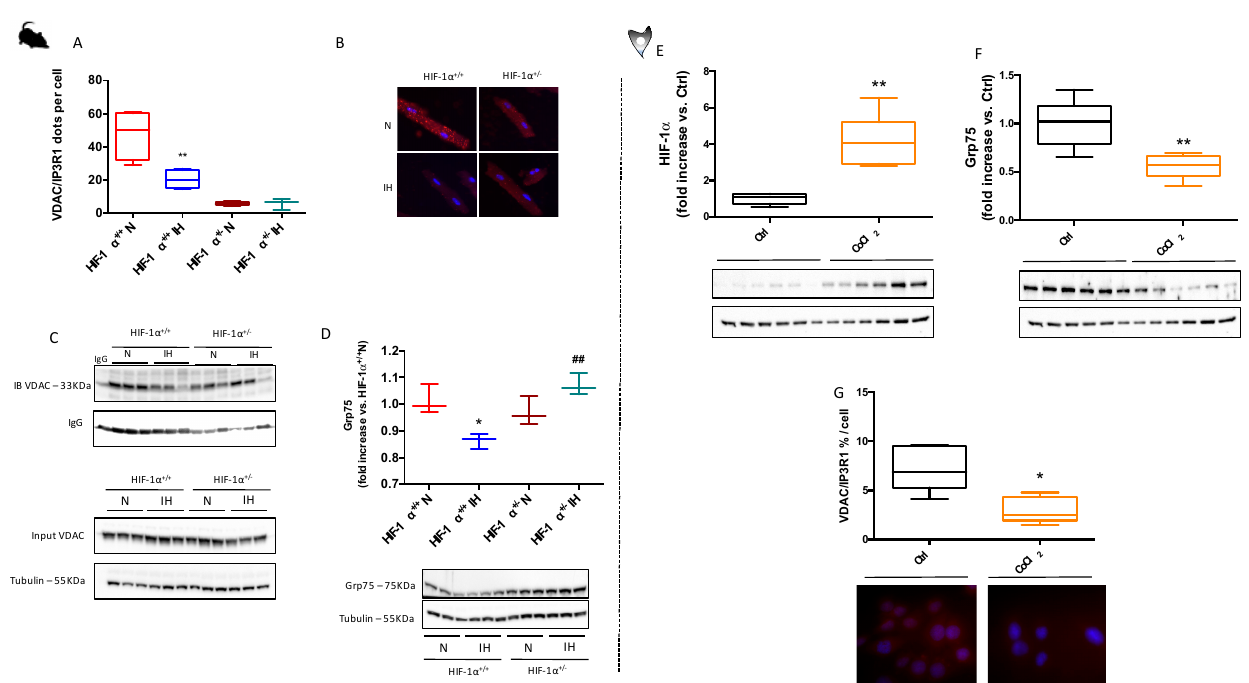
Figure 4. IH-induced MAM structural alteration is mediated by HIF-1. Left panels: HIF-1 α +/+ and HIF-1 α +/ − mice submitted to normoxia (N) or chronic intermittent hypoxia (IH). Quantification ( A ), and representative image ( B ), of voltage anion dependent channel (VDAC) and Inositol tri- Phosphate Receptor 1 (IP3R1) dots following proximity ligation assay (proximity < 0.4 nm in red; nucleus in blue-DAPI, n = 4–5, and immunoprecipitation of IP3R1 linked-protein followed by VDAC immunobinding (IB) ( C ), n = 3. Quantification and representative image of glucose regulated protein- 75 KDalton (Grp75) ( D ), n = 3. Right panels: H9c2 cells stimulated by cobalt chloride (CoCl 2 , 1 mM, 1 h). Quantification and representative images of hypoxia inducible factor 1 α (HI© α ) ( E ), and Grp75 ( F ), expression, and VDAC/IP3R1 proximity ( G ), n = 5. Data are expressed in median and min to max values and analyzed using Kruskal–Wallis followed by Dunn’s test; * p < 0.05; ** p < 0.01 vs. N; ## p < 0.01 vs. HIF-1 α +/+